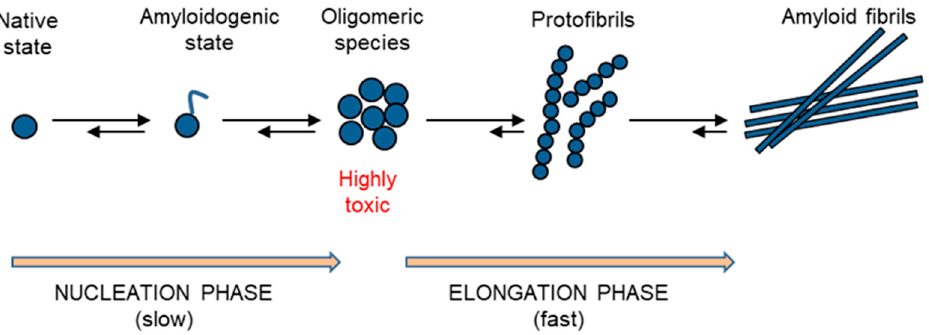
Figure 3. Schematic representation of the amyloid aggregation process. The process originates with the formation of amyloidogenic states, which are highly disordered and which possess an intrinsic propensity to further assembly into oligomeric species that are highly reactive (nucleation phase). The oligomeric species rapidly evolve to the formation of insoluble protofibrils and, eventually, the fibril growth proceeds by further association of protofibrils (elongation phase).